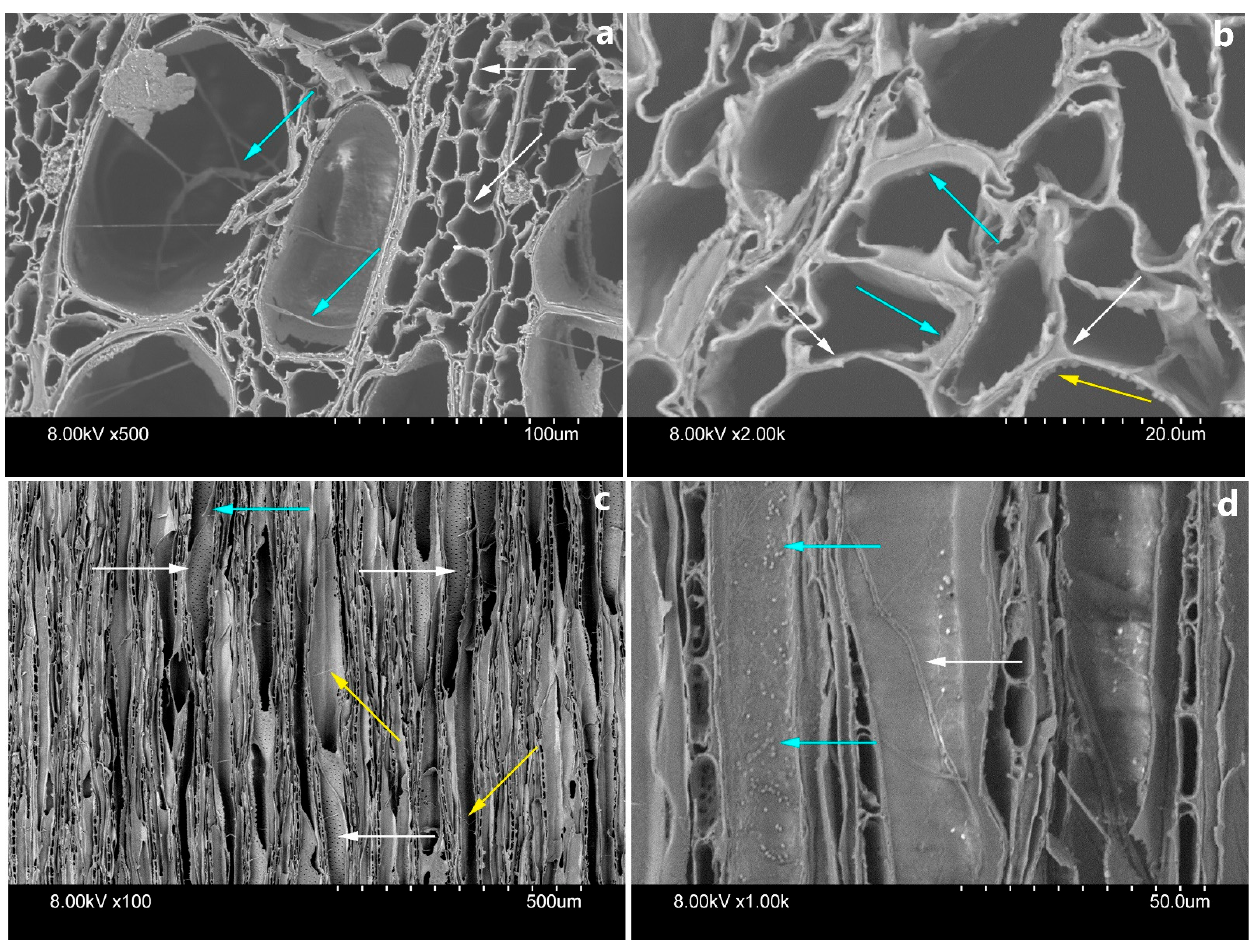
Figure 6. Scanning electron microscopy (SEM) micrographs of cross-sections from archaeological poplar ( a , b ) and tangential sections ( c , d ). Arrows indicate the damaged parts of archaeological wood samples.